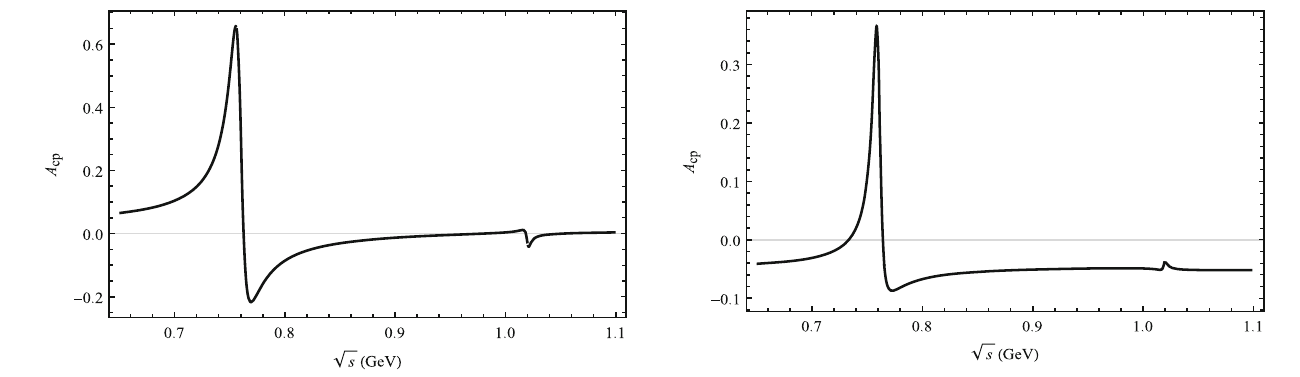
Fig. 5 Plot of A CP as a function of parameter values of CKM matrix elements for the decay channel of ¯ B 0